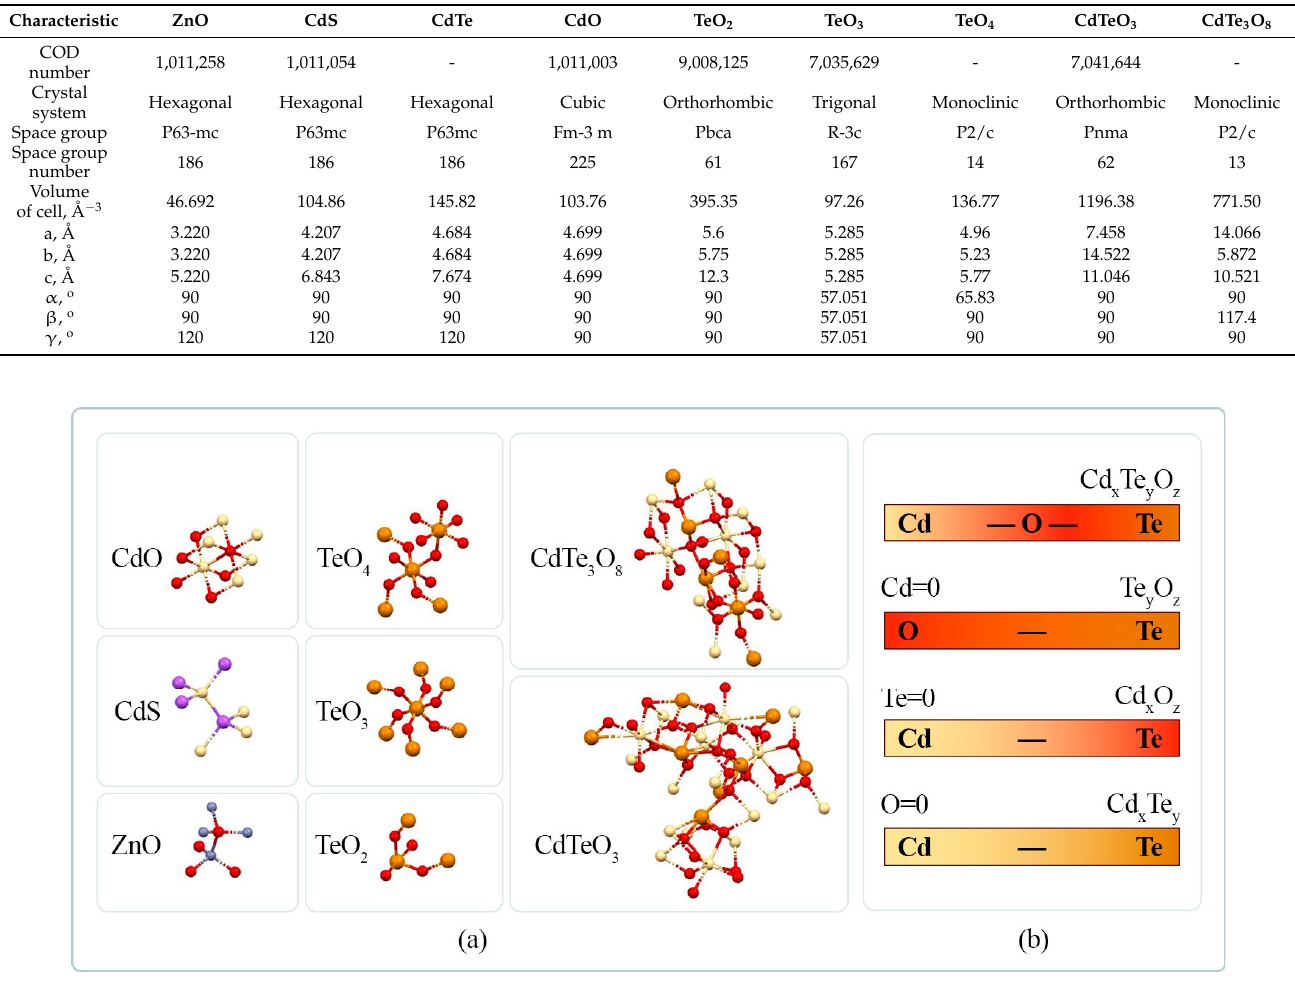
Figure 7. Crystal la tt ices of the materials that make up the Cd x Te y O z /CdS/ZnO heterostructure ( a ) and a schematic representation of probable Cd x Te y O z oxides at di ff erent concentrations of elements ( b ). Solid CdTe crystallizes in a hexagonal crystal la tt ice of the sphalerite type [70], and the cadmium and tellurium atoms each have four paired atoms of a di ff erent type which are located in the vertices of the tetrahedron. Instead, CdO crystallizes in a cubic rock salt- like crystal la tt ice. The Cd and O atoms each have six bonds with atoms of di ff erent types (Table 2). For these reasons, CdTe and CdS exhibit a crystal la tt ice match compared to the CdS and CdO pair. The absence of Raman peaks from CdTe indicates that Cd–O and Te– O bonds are formed by oxygen absorption, which may block the formation of Cd–Te bonds [71]. In addition, the formation of CdTe on the surface of CdS is energetically dis- advantageous compared to CdO because of the higher chemical activity of oxygen ions in the electrolyte, which may be represented by the hydroxyl group.